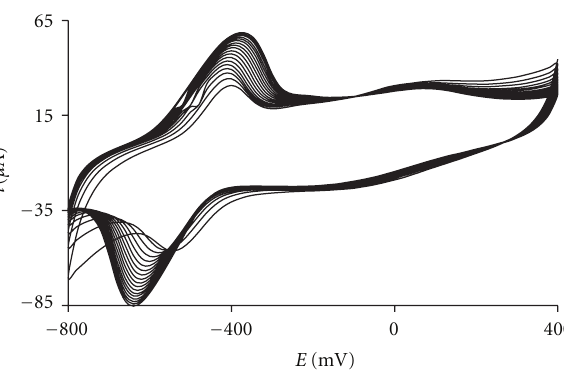
Figure 1: Cyclic voltammogram of 0.1M riboflavin at pH 7.0 on GCE.